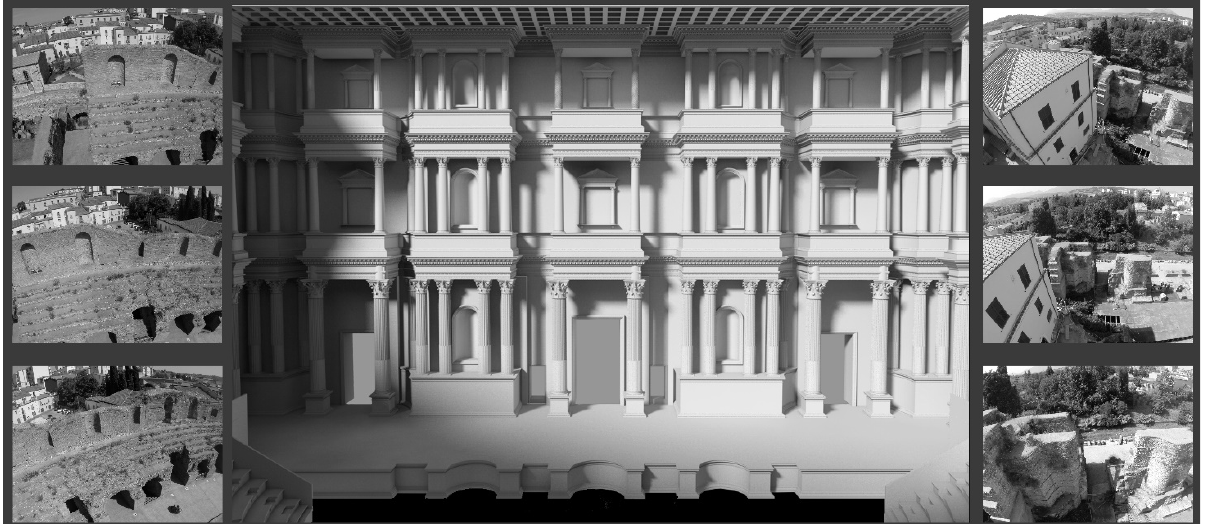
Figur e 8: Reconstruction of the scaenae frons.